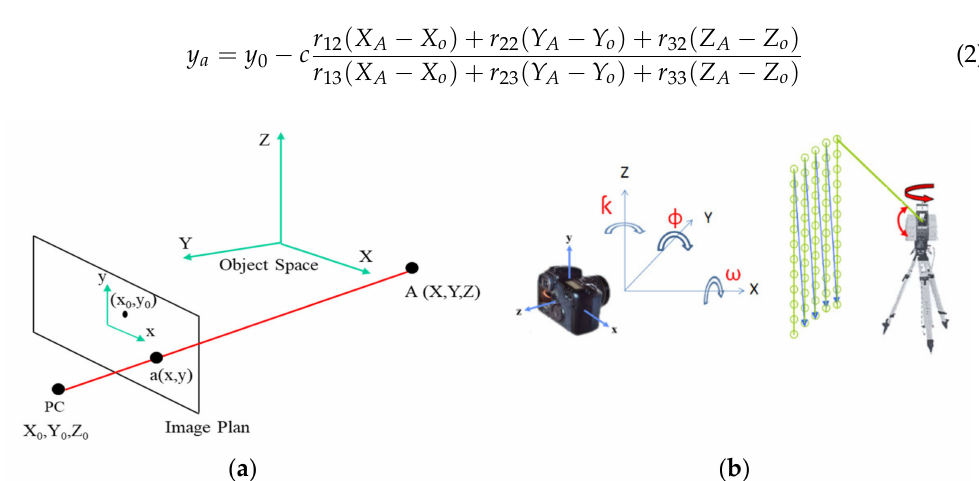
Figure 21. ( a ) Collinearity projection model; ( b ) camera registration parameters. The pixels of a source image that correspond to visible points are used to produce the true orthoimage, whereas invalid pixels that belong to the shadow (occluded area with no DSM data) are recognized and marked in white, as illustrated in Figure 22. The Figure depicts color photos acquired from a TLS-installed camera and a separate Canon EOS camera (12 Mega pixels). These images were processed to generate true orthophoto with ground sampling distance (GSD) of 1 mm used in texturing the BIM model as depicted in Figure 23. Since the orthophoto will have the same dimension as the corresponding HBIM surfaces, their warping will be accurate and reliable. Figure 24a depicts a large-scale true orthophoto (2 cm GSD) processed using TLS camera. The orthophoto was warped in HBIM of the village buildings and walls as depicted in Figure 24b. Figure 24c depicts As-Textured HBIM of the buildings using true orthophotos projected from different locations. It can be seen that some facades lack texture information. This is due to the fact that these facades are obscured from TLS stations and are unsampled, as shown in Figure